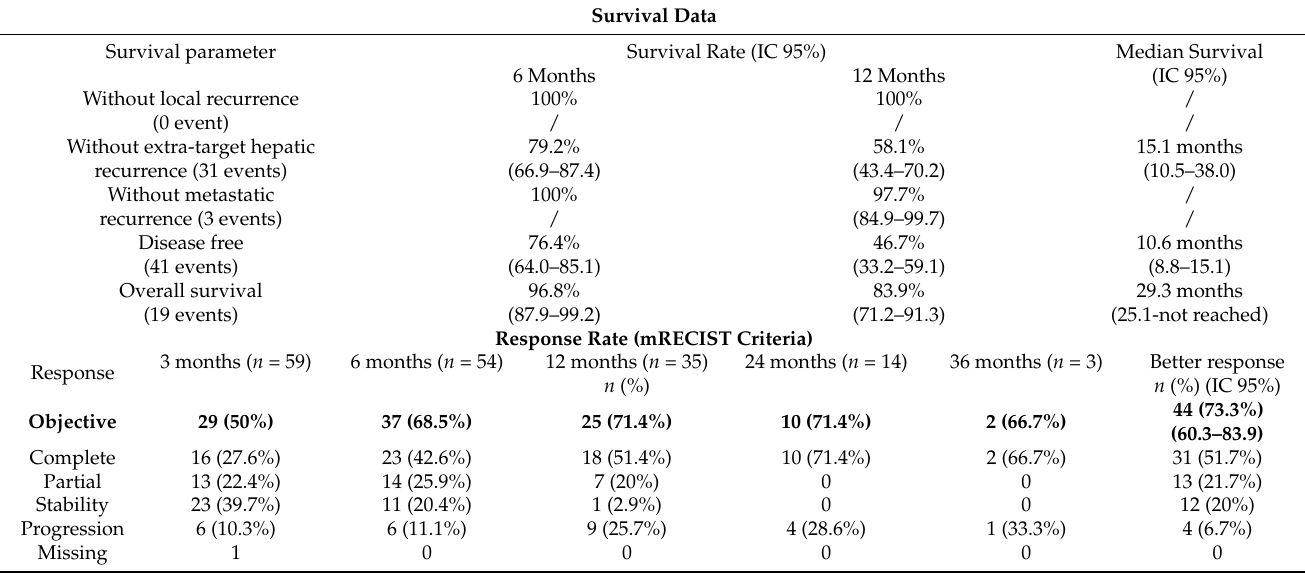
Table 4. Survival data and response rate to radiotherapy according to mRECIST criteria.